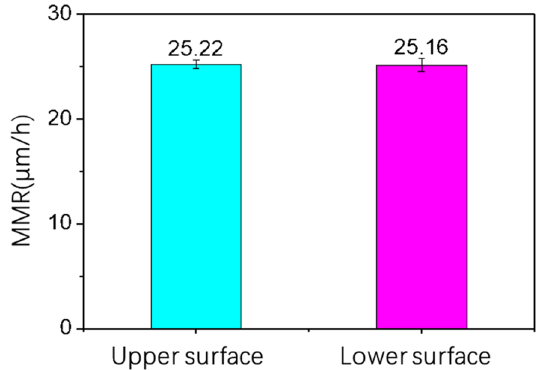
Figure 14 Materials removal rate of upper and lower surface